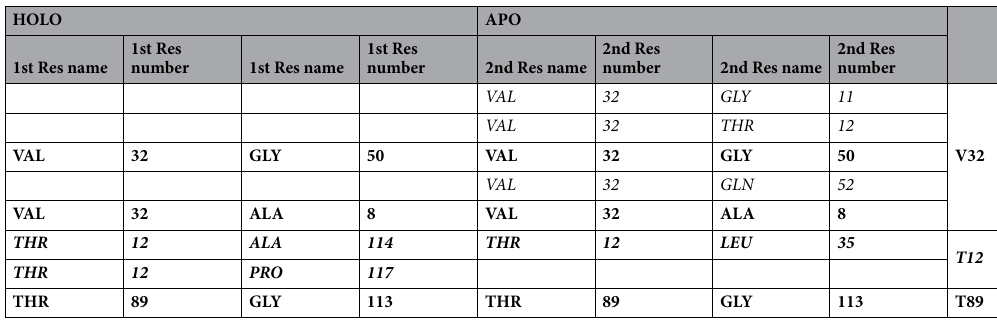
Table 1. H-bonds (HBs) comparison in APO-EcAII and EcAII-ASP. In bold HB conserved in APO-EcAII and EcAII-ASP, in italics HBs involving residues in the same region both in APO-EcAII and EcAII-ASP, and, in bolditalics HBs different in APO-EcAII and